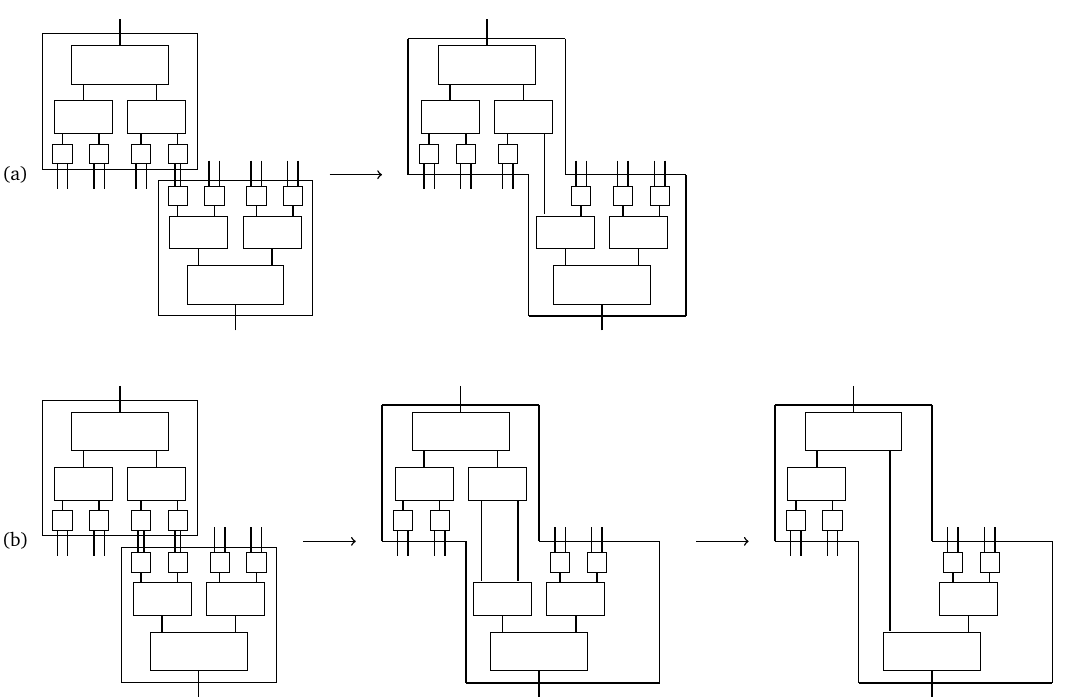
Figure 7: From left to right the contraction of a pair of aligned tensor trees is shown. Cases (a) and (b) correspond respectively to contractions which reach one and two layers deep in each tree. In the end the result is another tensor tree. Note that at each stage there is a pair of indices to be contracted which form a cycle containing just two tensors.